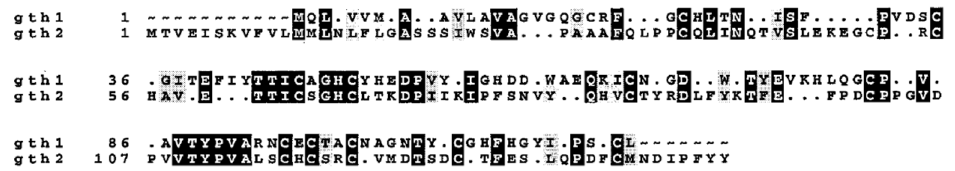
Figure 15. Nucleotide sequences of blue gourami FSH- β ( A ) and LH- β ( B ). The amino acid sequence. of each hormone appears in three-letter code. The GenBank accession numbers of these sequences are AF157630 and AF157631, respectively [34].